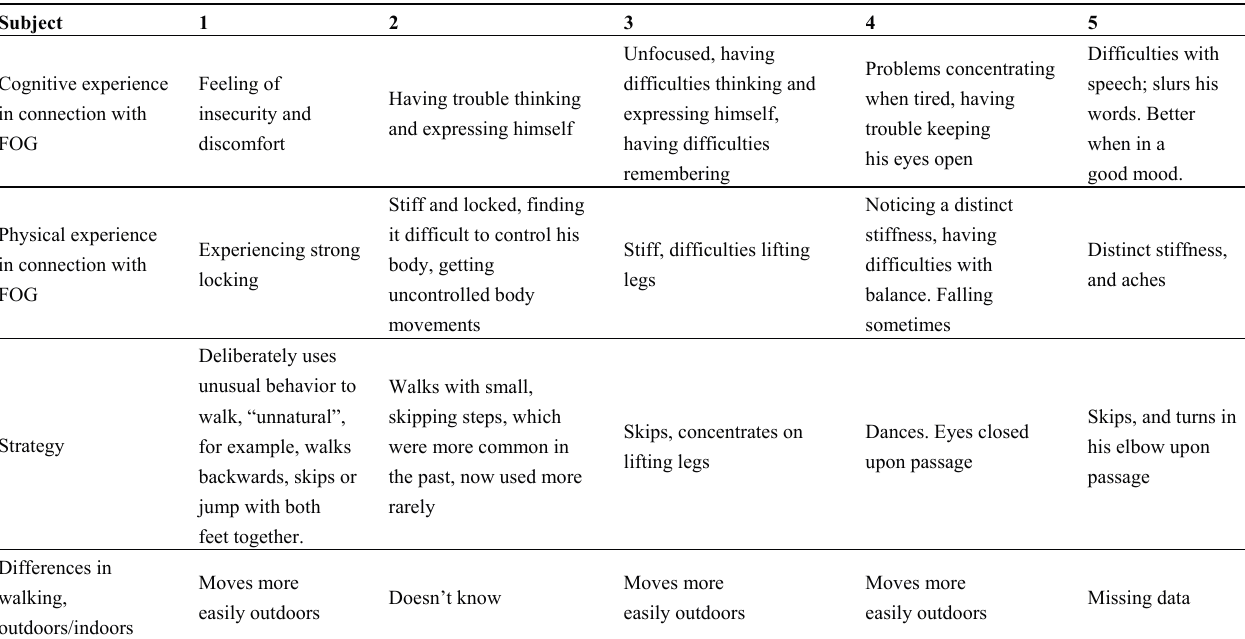
Table 1. Results from the first interview in a summary